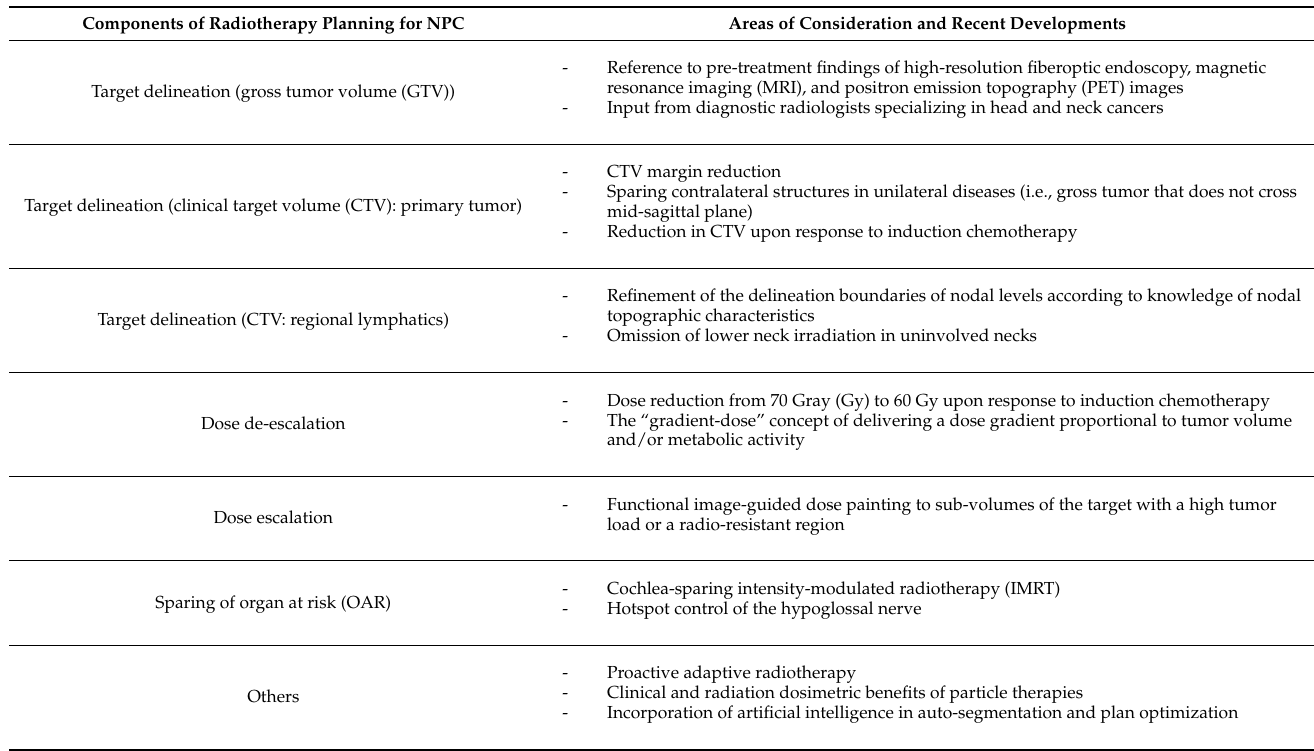
Table 1. Summary of current radiotherapy considerations for nasopharyngeal carcinoma (NPC). Components of Radiotherapy Planning for NPC Areas of Consideration and Recent Developments Target delineation (gross tumor volume (GTV))